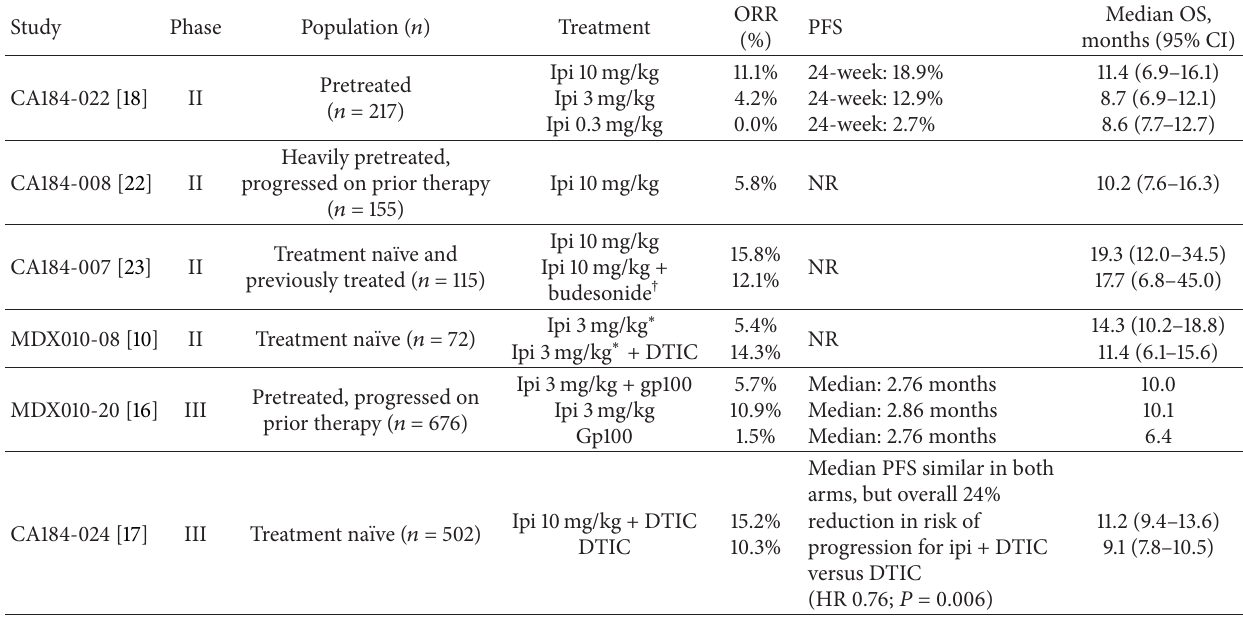
Table 1: Ipilimumab efficacy in phase II and III trials